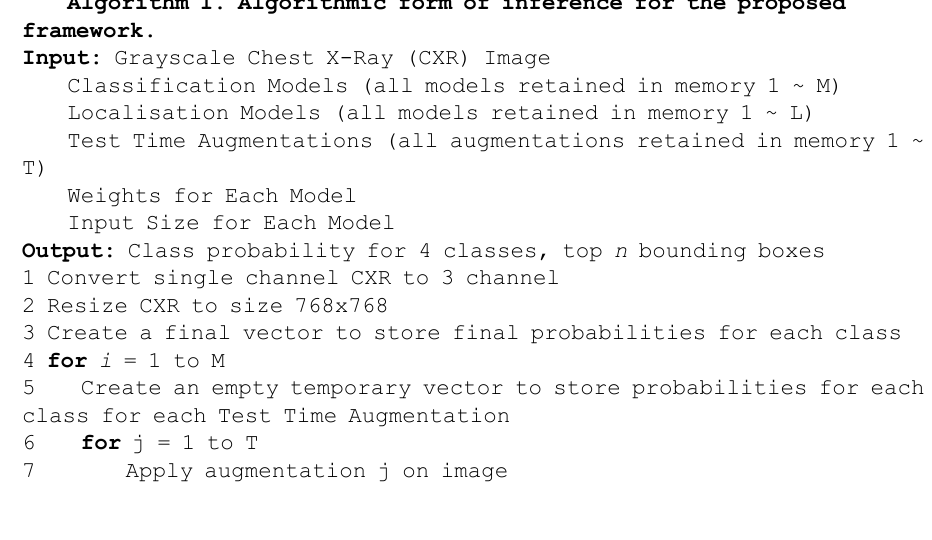
Algorithm 1. Algorithmic form of inference for the proposed framework .